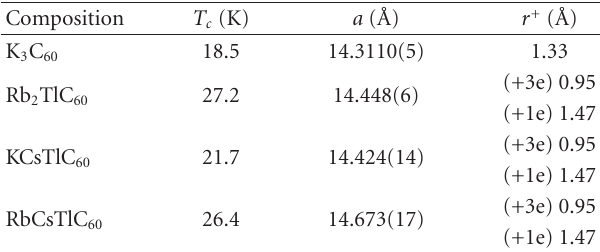
Table 1: Composition, superconducting transition temperature ( T c ), crystal lattice parameter ( a ), and ionic radius of heterometal ( r + ) for some investigated